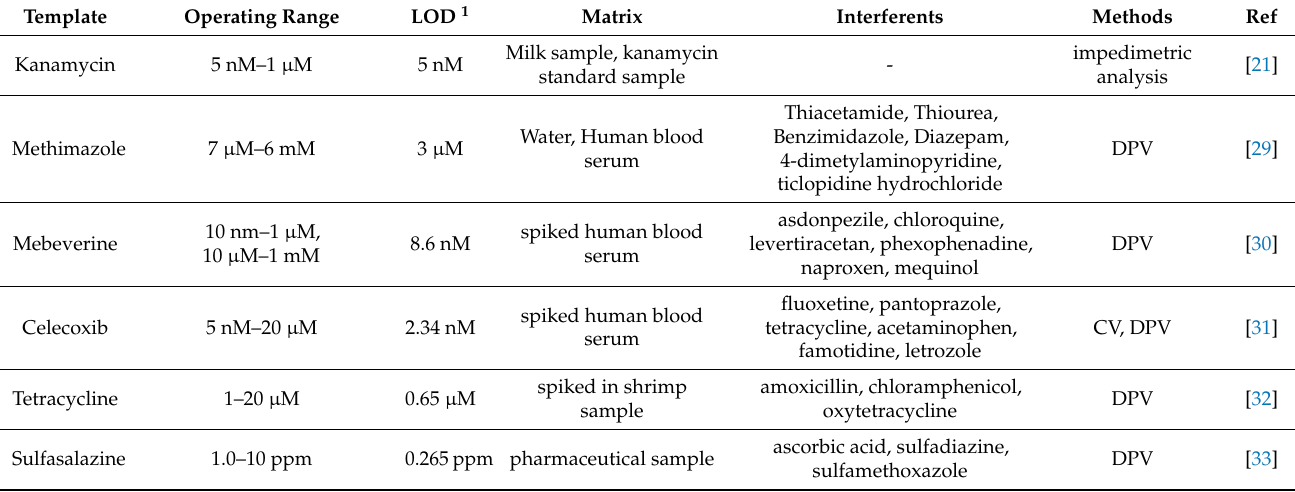
Figure 5. Structural formulae of some drugs that can be detected using MIPPy-based sensors. Table 1. Drug sensing performance of MIPPy-based